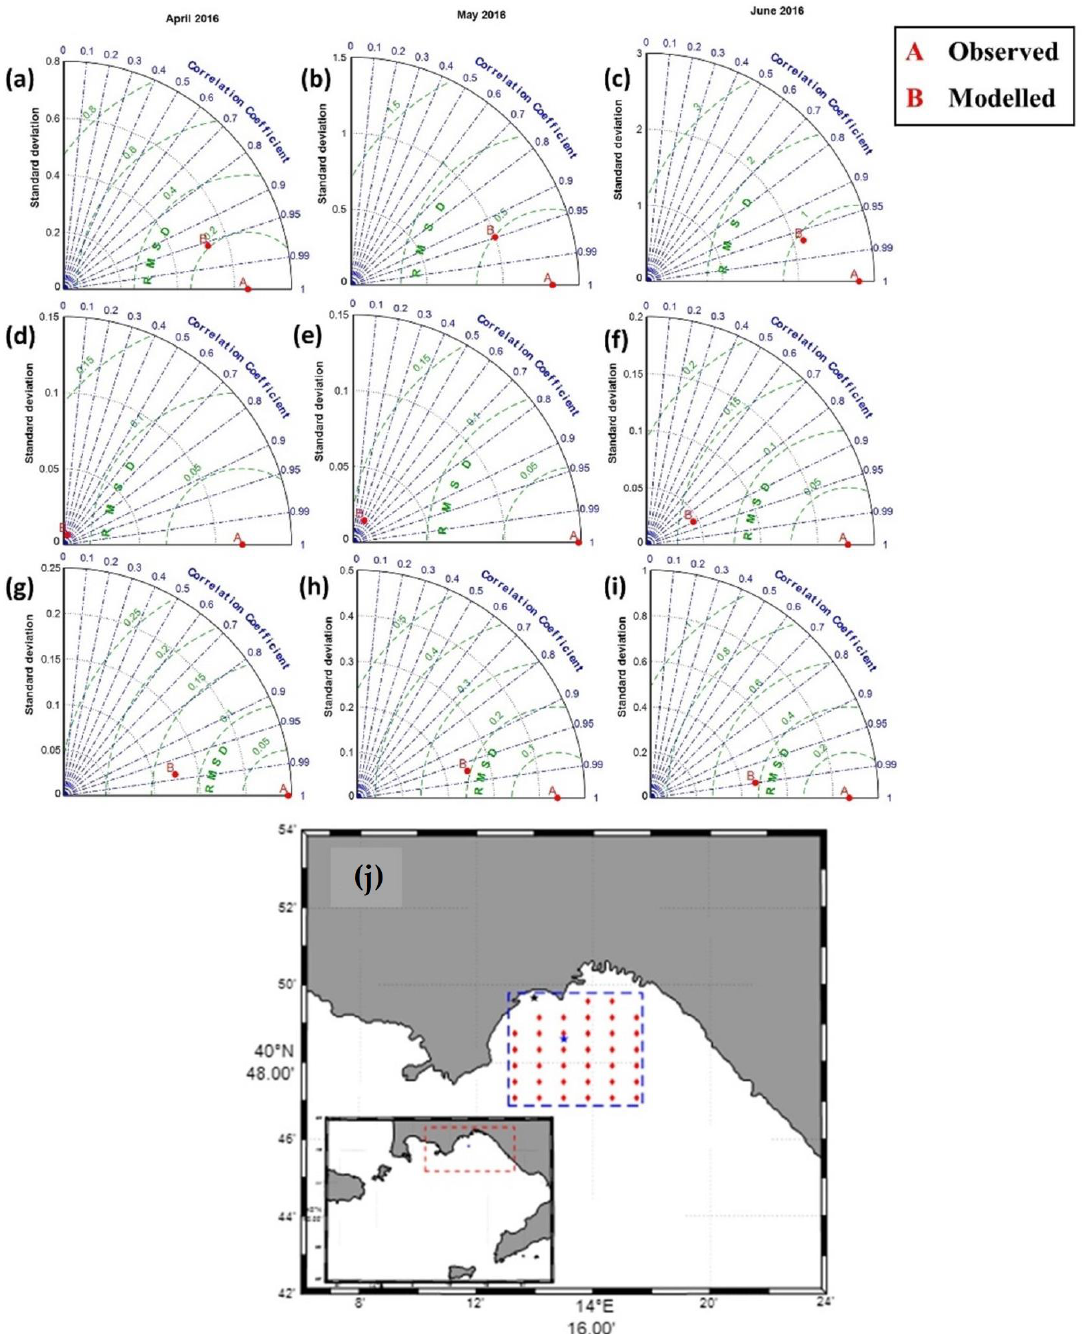
Figure 8. Taylor diagrams of T ( a ), S ( d ) and ρ ( g ) for April 2016. ( b , e , h ) and ( c , f , i ) are the same but for May and June 2016, respectively. ( j ) CROM domain simulation area utilized for the observe-simulated data comparison.